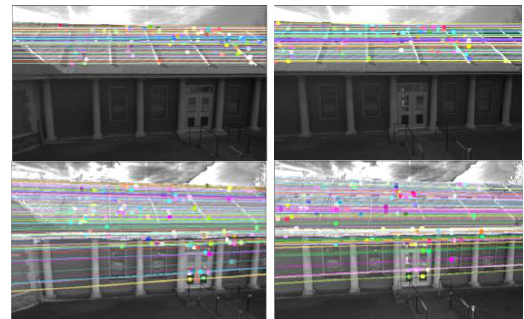
Figure 15. Feature matching with epipolar constraint. (Top: